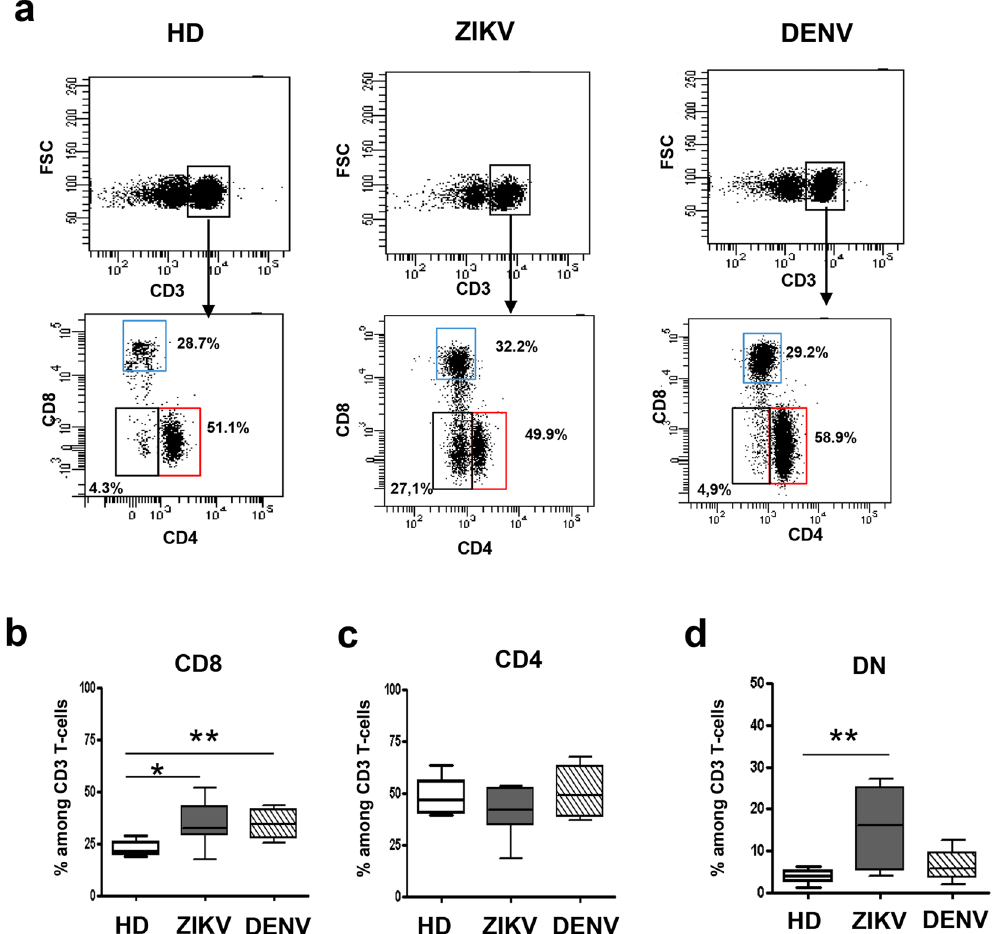
Figure 1. T-cell subsets during ZIKV infection. Flow cytometric panels of CD3, CD8, CD4 and DN T-cells in one representative ZIKV-infected, one DENV-infected patient and in one representative HD ( a ). The frequency of CD8 ( b ), CD4 ( c ) and DN ( d ) T-cells was compared in HD (white bars), ZIKV (grey bars) and in DENV (hatched bars). * p < 0.05, ** p <